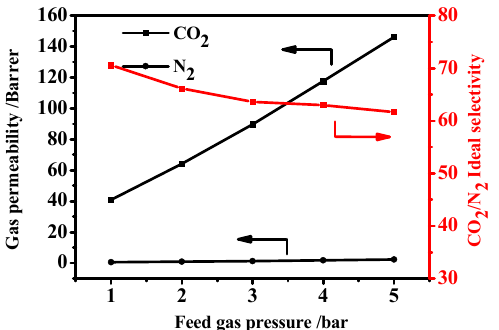
Figure 9. Gas separation performance of PM5 MMM under different feed pressure.